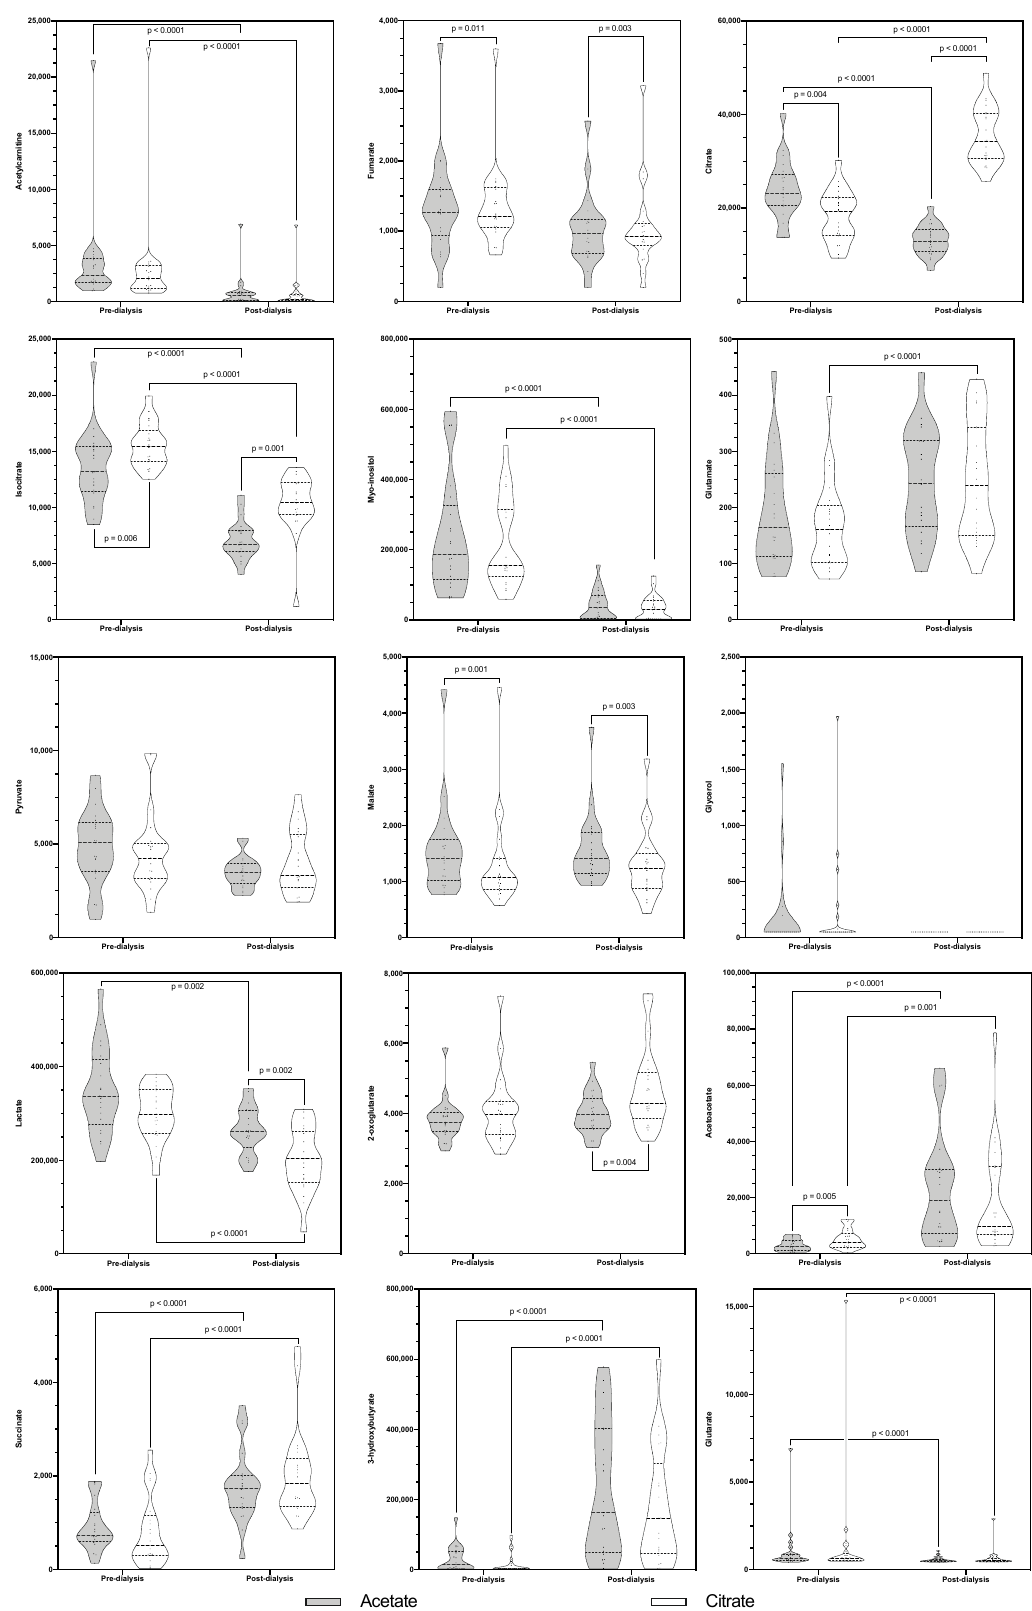
Figure 2. Violin plot representing the pre- and post-dialysis measured concentrations of the fifteen studied metabolites with each dialysate. Statistically significant differences are marked.